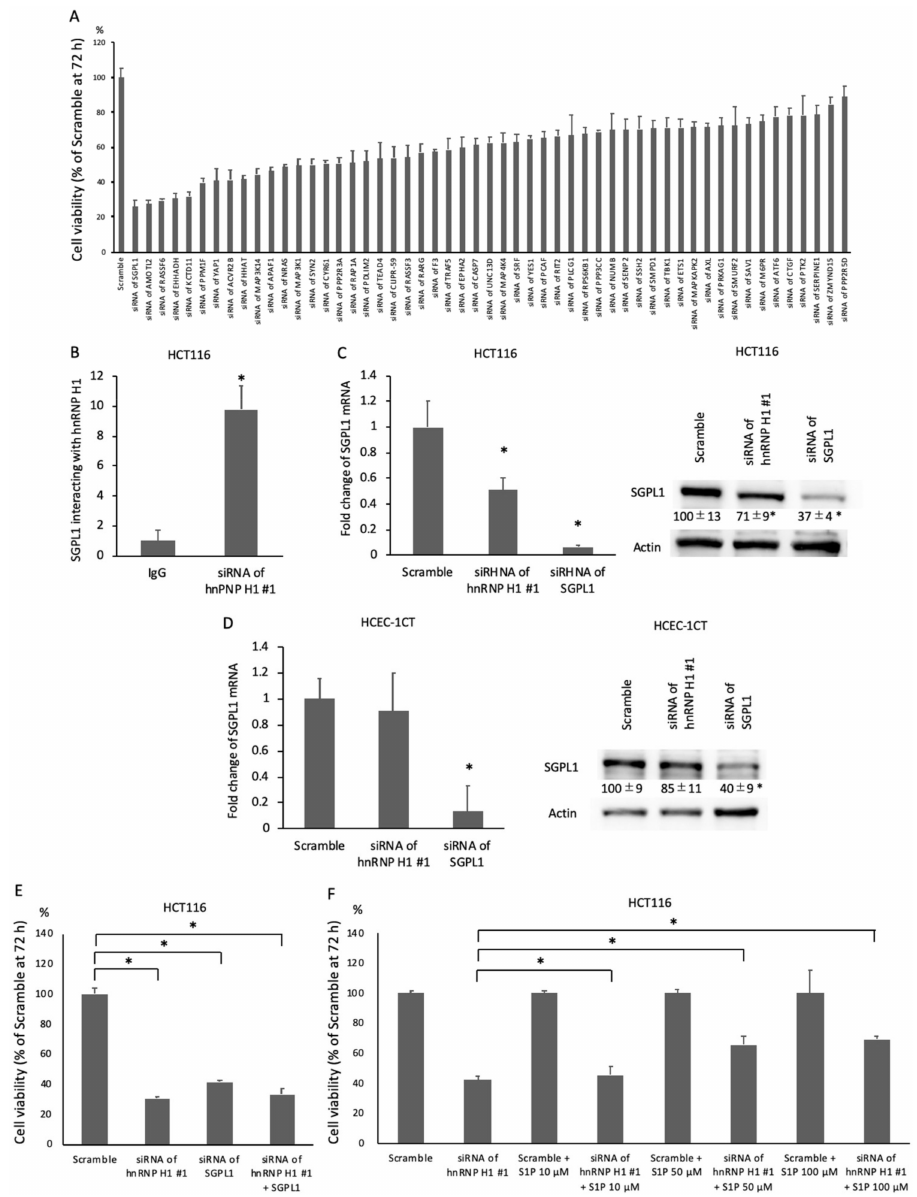
Figure 3. hnRNP H1 upregulated sphingosine-1-phosphate lyase 1 (SGPL1) mRNA and promoted colorectal cancer progression. ( A ) The SRB assay ( n = 5) showed that SGPL1 downregulation resulted in the strongest inhibition of cell growth in HCT116 cells. ( B ) RNA immunoprecipitation combined with RT-PCR ( n = 3) confirmed the direct binding of hnRNP H1 and SGPL1 mRNA. ( C ) RT-PCR ( n = 3) and western blotting ( n = 3) showed the decrease in SGPL1 mRNA and protein in hnRNP H1-downregulated HCT116 cells. ( D ) RT-PCR ( n = 3) and western blotting ( n = 3) showed that the downregulation of SGPL1 mRNA and protein was not observed in hnRNP H1-downregulated HECE-1CT cells. ( E ) The SRB assay ( n = 5) showed that an additional tumor-suppressive e ff ect was not observed by SGPL1 downregulation. ( F ) The SRB assay ( n = 5) showed that cell growth was significantly increased in the hnRNP H1-downregulated HCT116 cells with S1P in a concentration-dependent manner compared to those without sphingosine-1-phosphate (S1P). The error bars show the SD. * p < 0.05 by Student’s t